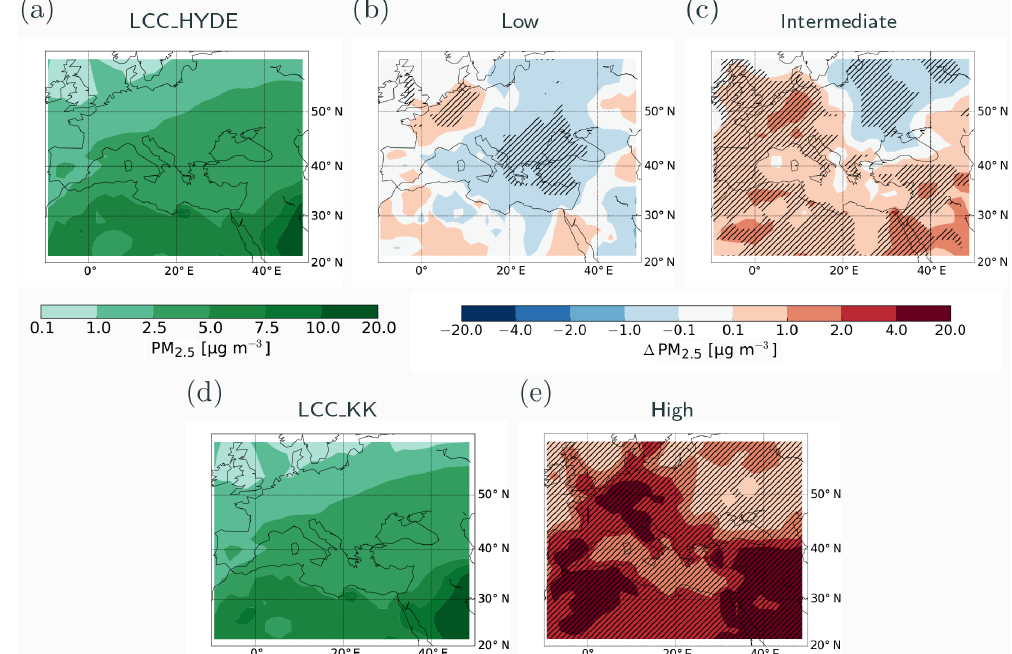
Figure 8. The background surface PM 2 . 5 concentrations ( a LCC_HYDE; d LCC_KK) and the changes in PM 2 . 5 surface concentrations due to anthropogenic aerosol emissions for the low ( b LCC_HYDE_low), intermediate ( c LCC_HYDE_int), and high ( e LCC_KK_high) emission scenarios. Statistically significant changes (5% significance level; N = 20) are